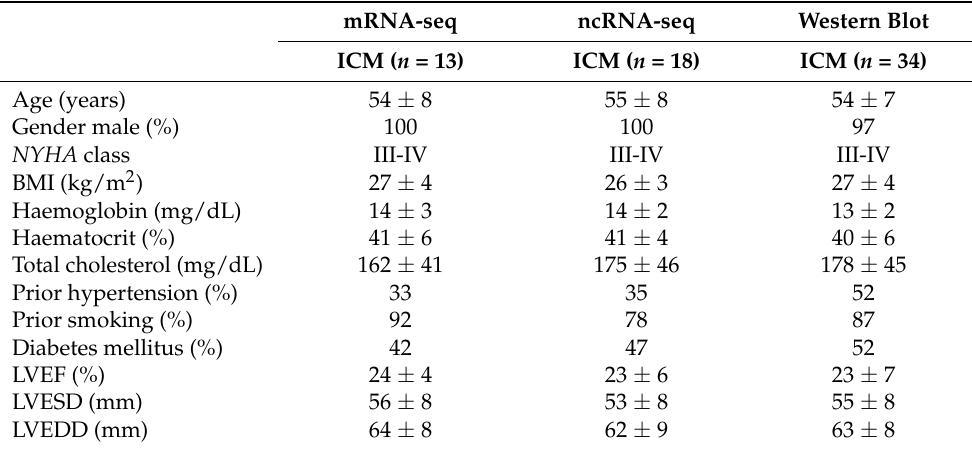
Table 1. Clinical characteristics of ischemic cardiomyopathy